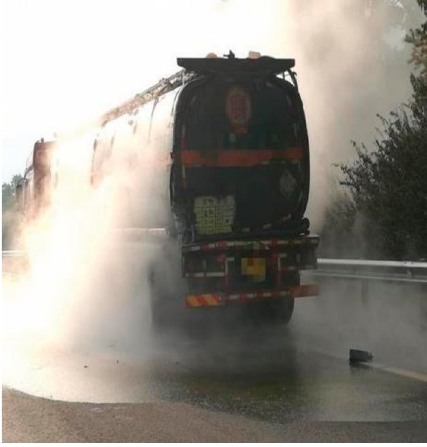
Figure 2: A hydrochloric acid truck